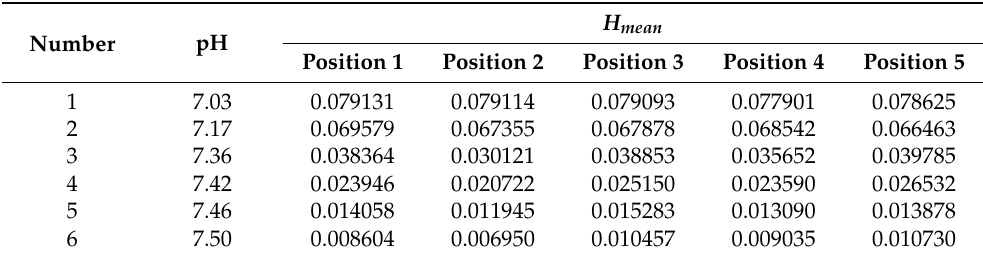
Table 3. H mean and pH value measured by pH meter of orifice plate images of 6-well liquid, collected at different positions.